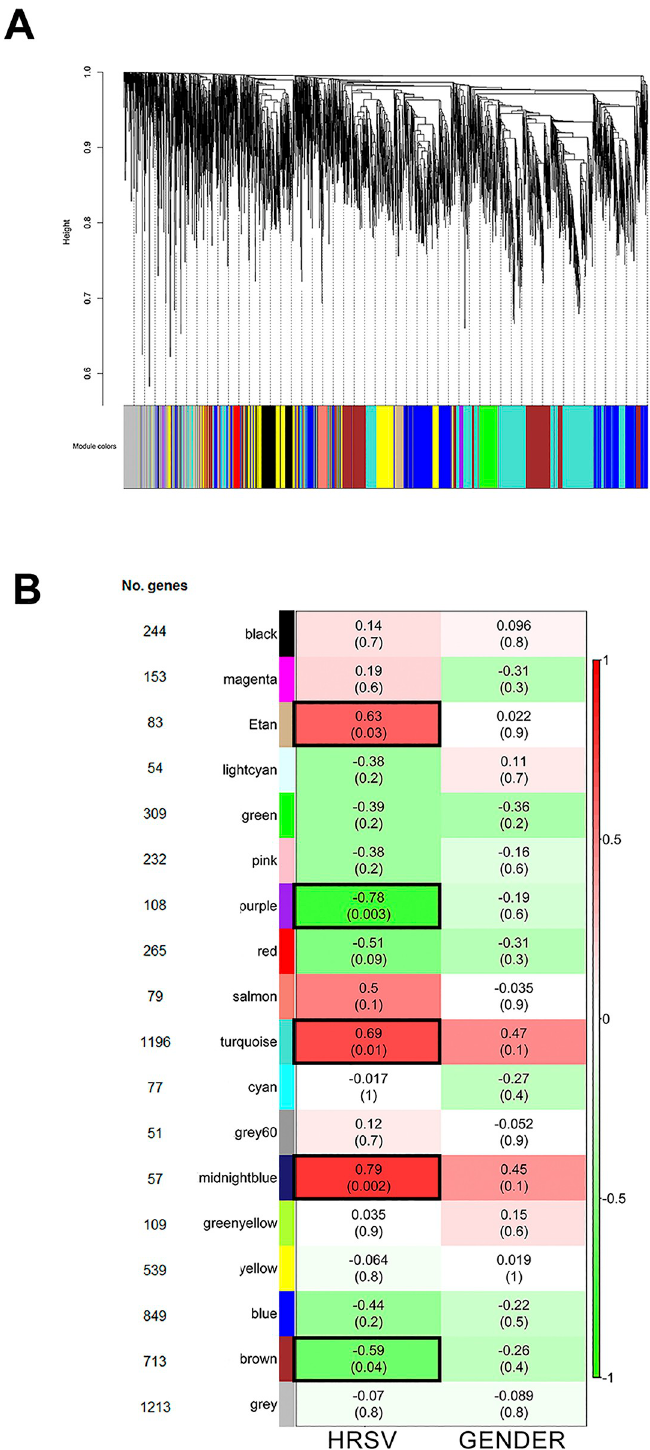
Fig 2. WGCNA dendrogram and modules correlation with HRSV group and gender. A - Hierarchical clustering dendrogram and module identification, indicated by different colors; B - Heatmap of the relationship between modules (MEs) and traits (infection and gender). Only the HRSV group is shown. Numbers inside each colored box are the correlation coefficients between the ME and the specific trait, with p-value between brackets. The same values are true for the HRV group, but with an opposite correlation coefficient signal. The more intense the color of the box, the more